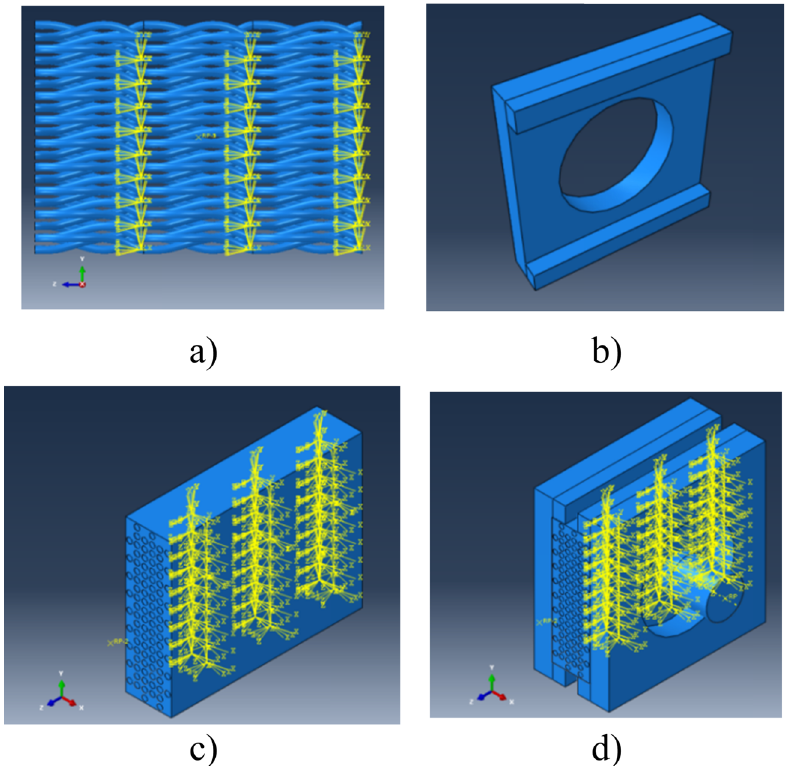
Figure 11: Finite element model of 3D four - directional braided composites: ( a ) yarn, ( b ) positioning fi xture, ( c ) braided composite overall model, and ( d ) impact overall